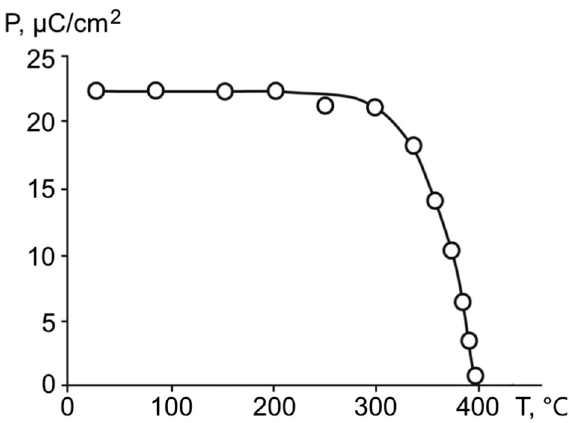
Figure 6. The temperature dependence of the spontaneous polarization for the ferroelectric BaZrO 3 /BaTiO 3 superlattice.